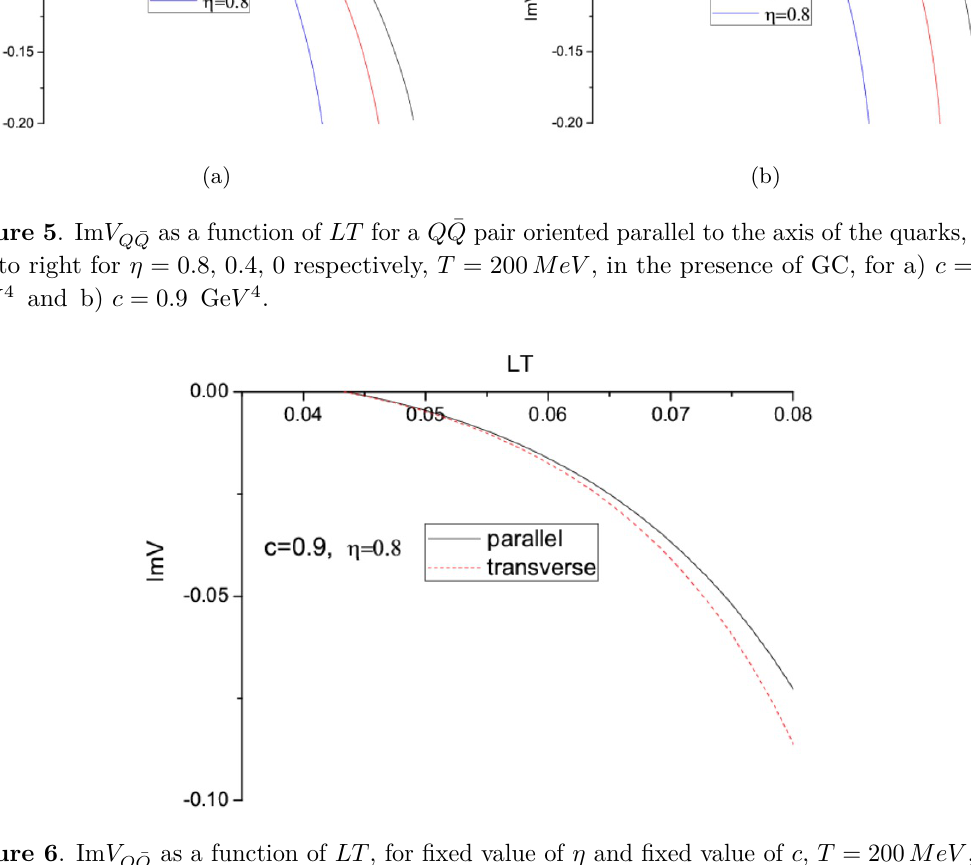
Figure 6 . Im V as a function of LT , for fixed value of η and fixed value of c , T = 200 MeV , as a Q ¯ Q comparison between the parallel and the transverse cases. The (right) black line shows parallel case and the (left) red line shows transverse